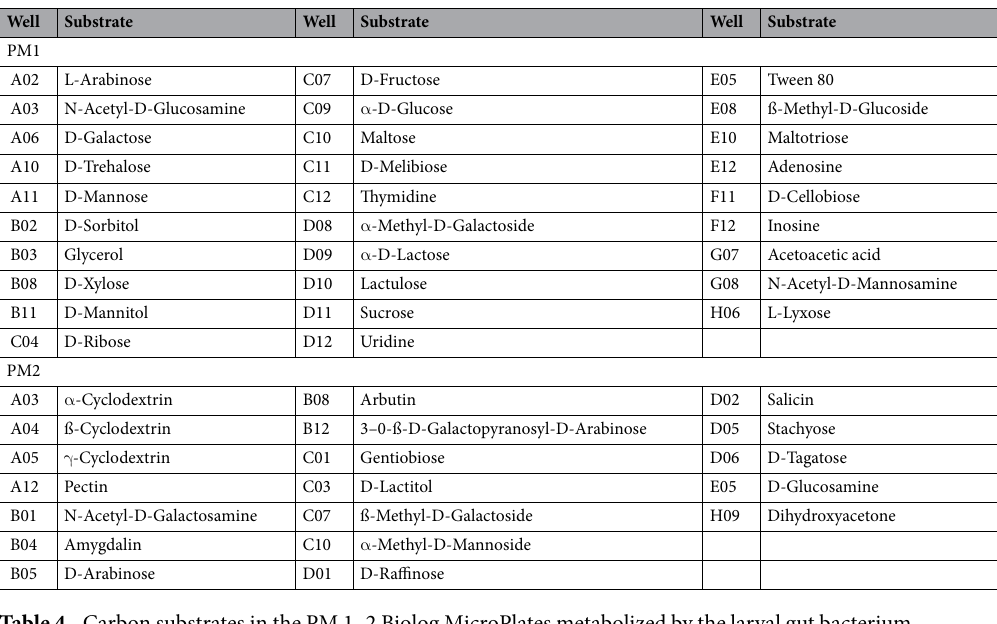
Table 4. Carbon substrates in the PM 1–2 Biolog MicroPlates metabolized by the larval gut bacterium Enterococcus mundtii from the diamondback moth a . a Content listed in the columns “Well” and “Substrate” refer to the layout of the Biolog PM Microplate; the number in the Well column indicate the substrates tested in the Biolog PM